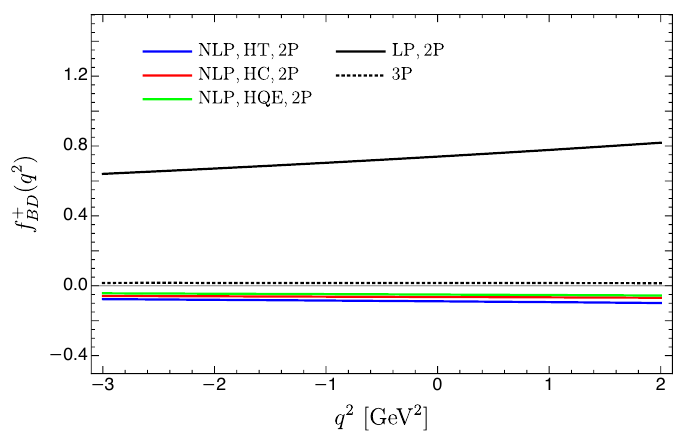
( q 2 ) at different q 2 . The leading power BD ( q 2 ) BD